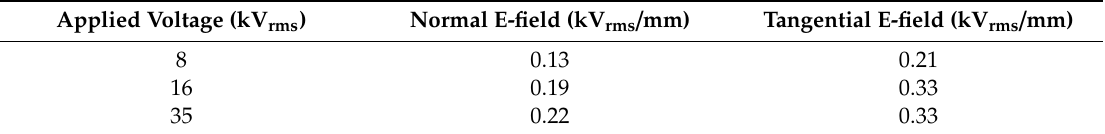
Table 1. Magnitude of the first maximum of the E-field component as a function of applied